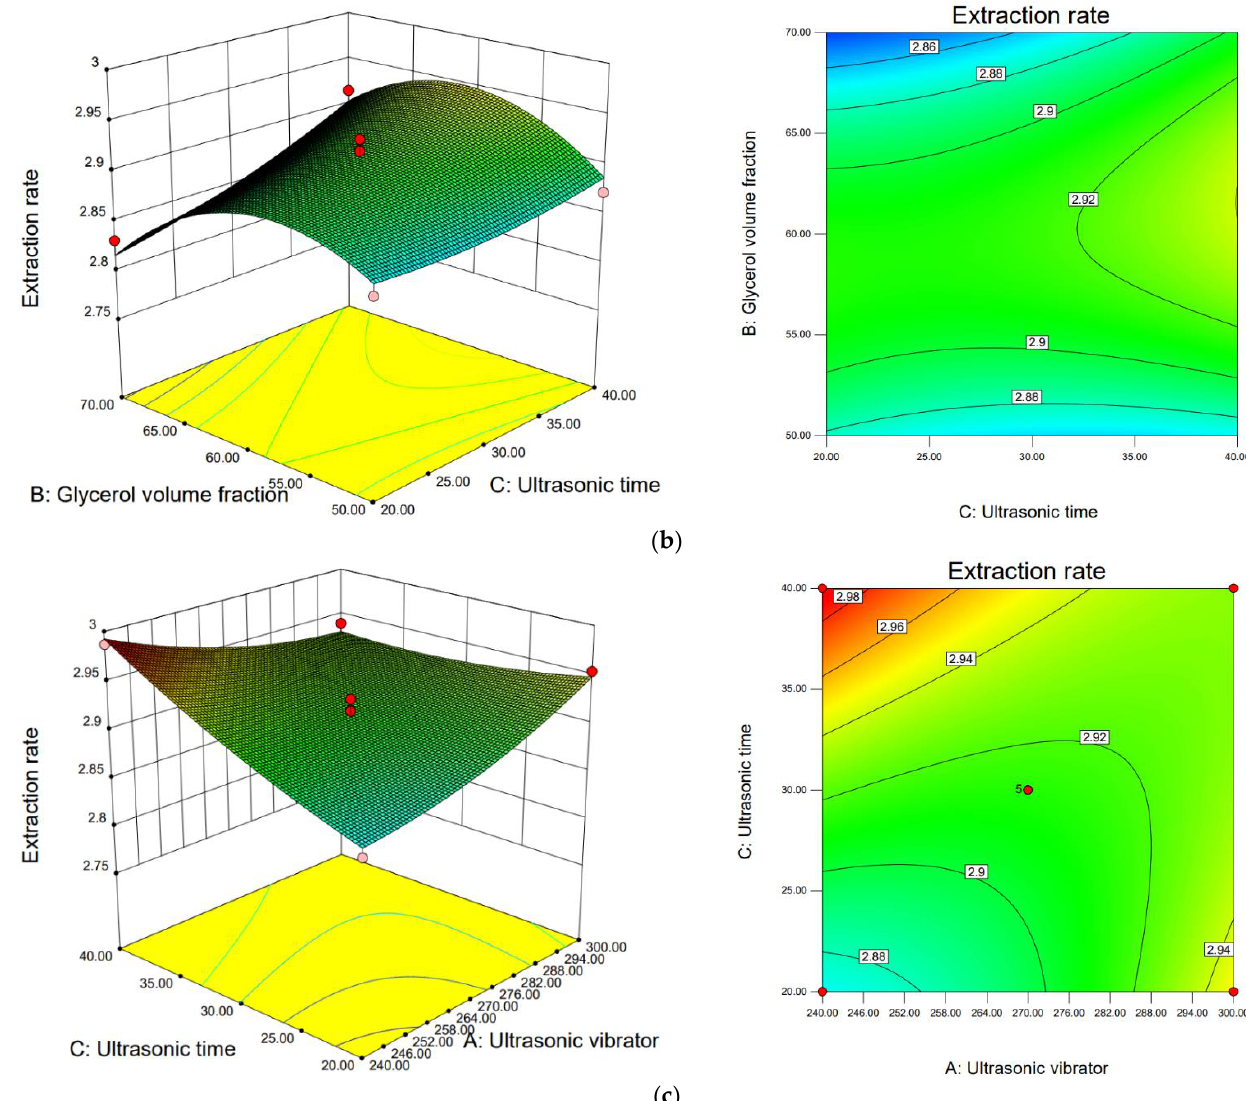
Figure 8. Response surface plots showing the effects of variables on the average extraction yield of CGA: ( a ) interaction of the ultrasonic vibrator and glycerol volume fraction, ( b ) interaction of the glycerol volume fraction and ultrasonic time, and ( c ) interaction of the ultrasonic time and ultrasonic vibrator.